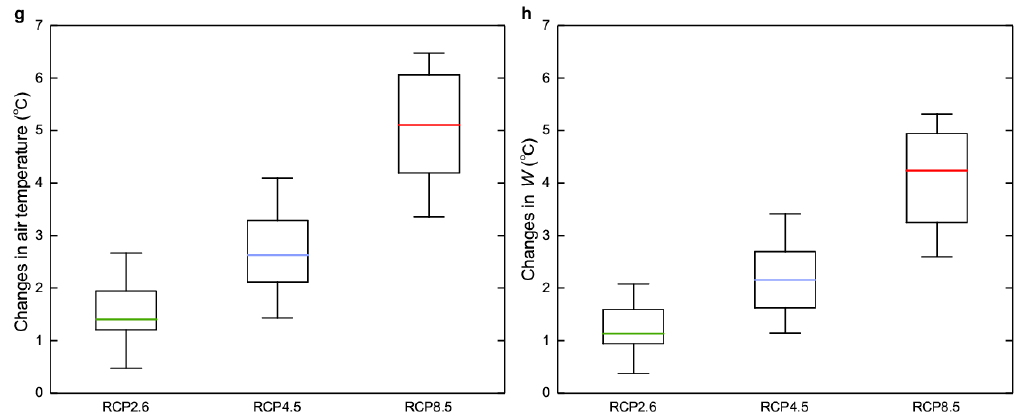
Figure 2. Changes in annual mean air temperature (shading) during 2076–2095 relative to 1986–2005 and multi-model standard deviation (contour) under ( a ) RCP2.6, ( c ) RCP4.5, and ( e ) RCP8.5. ( g ) shows the corresponding range of projected spatially averaged increases in annual mean temperature over global land based on the results of CMIP5 GCMs used. Panels ( b , d , f , h ): same as ( a , c , e , g ) except for annual mean W .